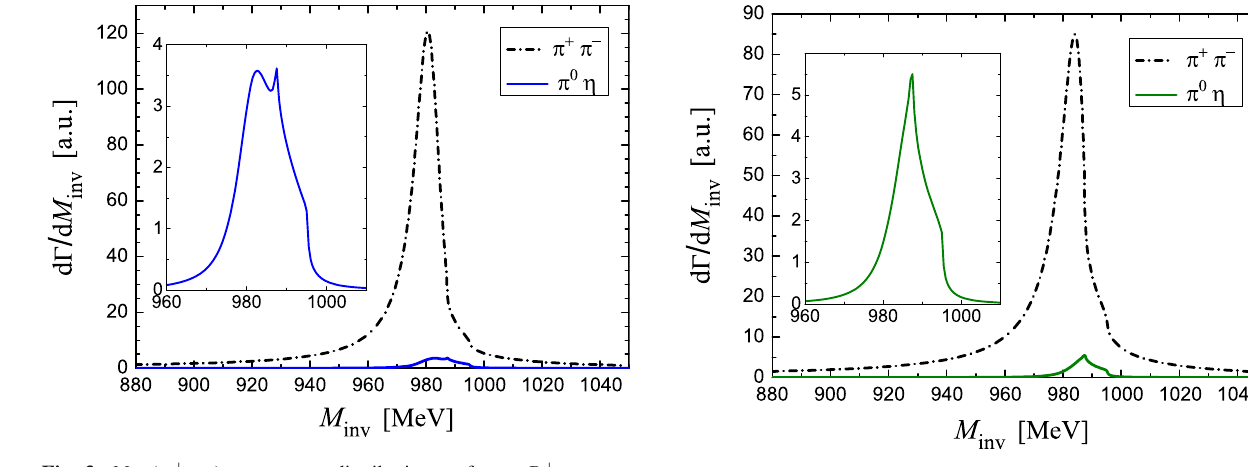
Fig. 4 M inv (π + π − ) mass distribution for D + s → e + ν e f 0 ( 980 ), f 0 ( 980 ) → π + π − decay, and M inv (π 0 η) mass distribution for D + s → e + ν e a 0 ( 980 ), a 0 ( 980 ) → π 0 η decay. (With η − η (cid:4)